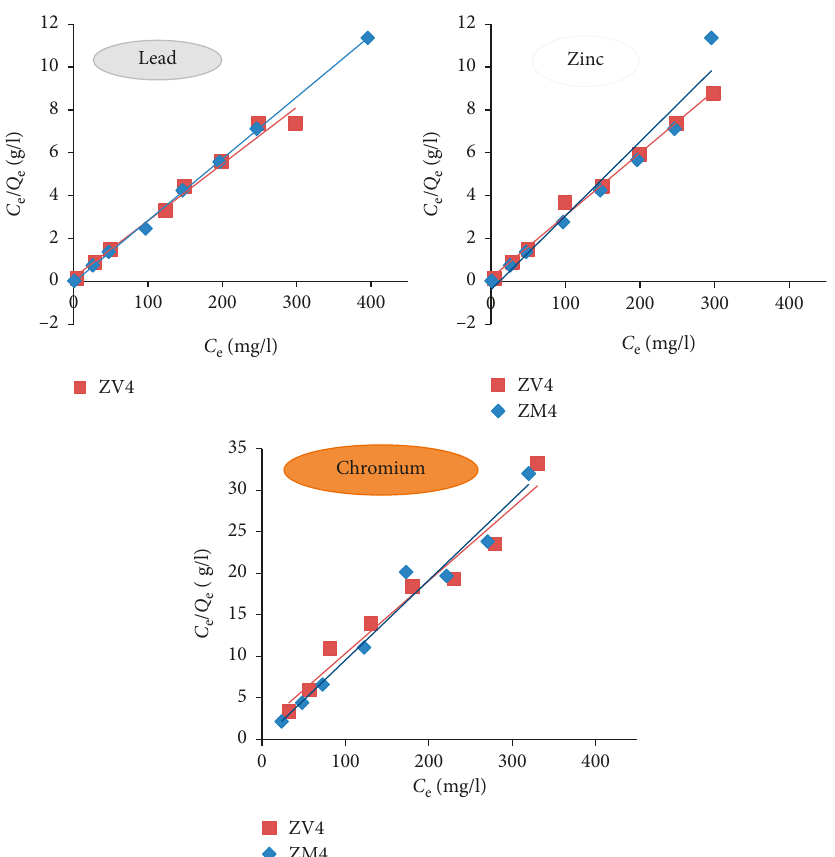
Figure 11: Langmuir isotherm representing variation of adsorption C